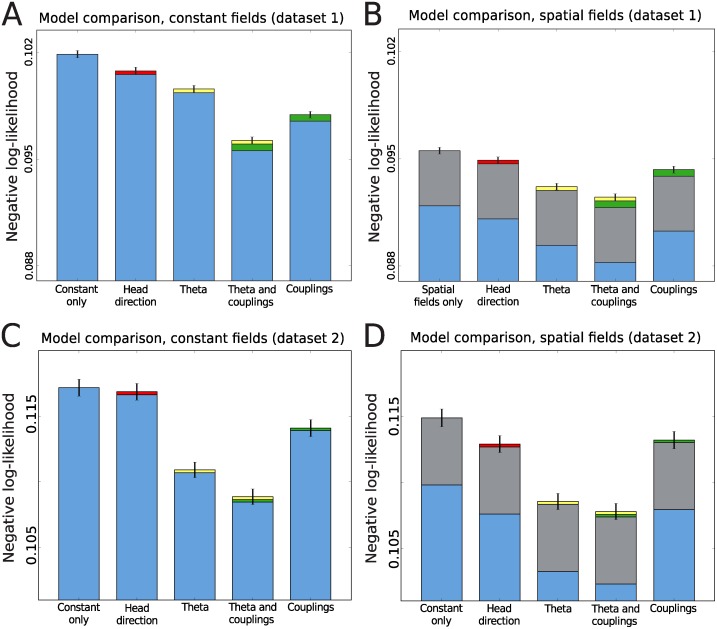
Statistical importance of the parameters.The negative log-likelihood per cell per time bin for the constant field model (A: data set 1, C: data set 2) and Gaussian field model (B: data set 1, D: data set 2) with different covariates included. Smaller values correspond to better explanatory power. The blue segment of the bar shows the negative log-likelihood. Adding parameters to a model will yield a log-likelihood-value greater than or equal to the model with fewer parameters. To avoid overfitting by including parameters, we performed an Akaike correction on the log-likelihood (see Material and Methods). The value of the Akaike-correction is shown for each covariate on top of the negative log-likelihood (blue) for each model: head direction (red), theta preference (yellow), and couplings (green). In (C, D), grey is the Akaike-correction due to the Gaussian spatial fields. These two plots show that adding the couplings always increases the explanatory power of the model, e.g. for the model with theta including couplings reduces the negative log-likelihood more than the penalty from the Akaike-correction for the added number of parameters.